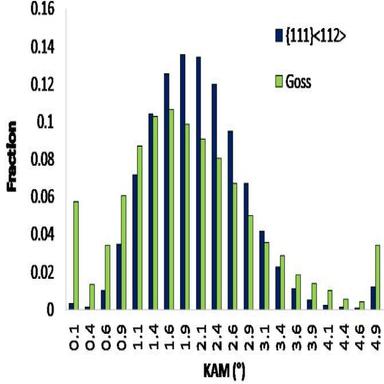
Distribution of KAM parameter for Goss sub-grains in shear bands and surrounding grains. Sample HR5 after the second cold rolling CR2.